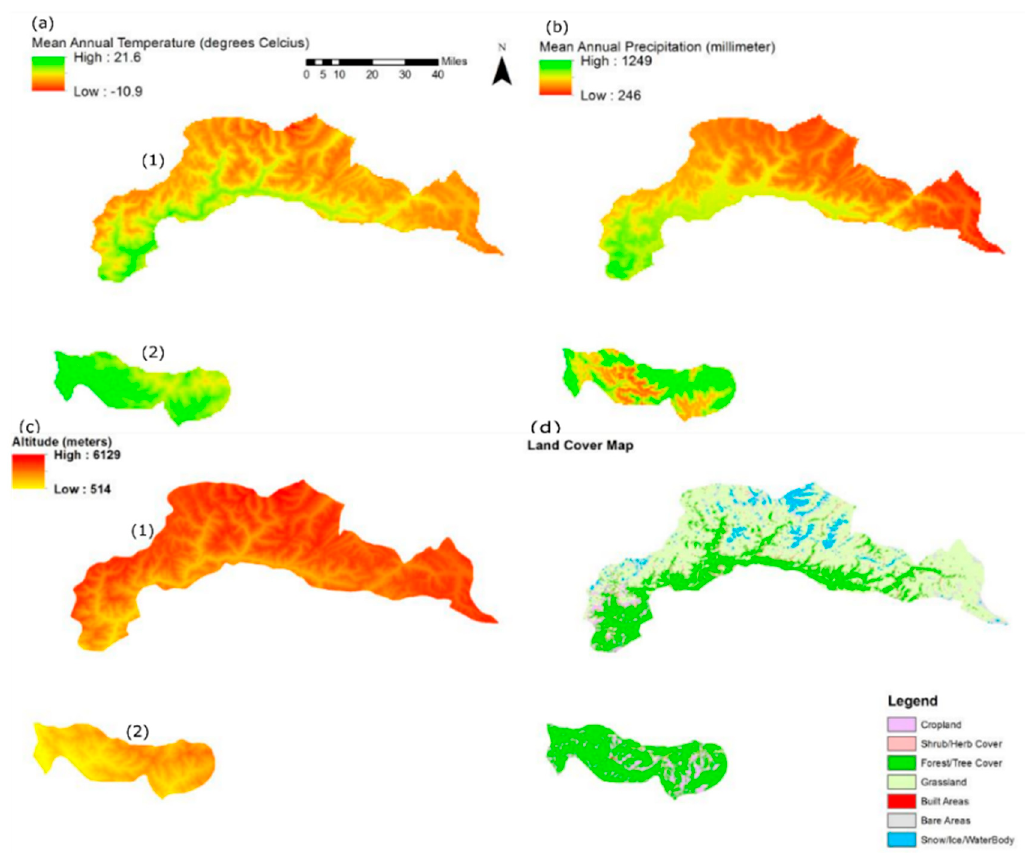
Figure 2. Topography, climatic conditions, and land cover of Neelum and Bagh in AJK. The climatic variables ( a , b ) were downloaded from www.worldclim.org. Altitude ( c ) was derived from the digital elevation model of NASA’s Shuttle Radar Topography Mission (SRTM) at 30 m spatial resolution. The land cover map ( d ) is extracted from the “The European Space Agency Climate Change Initiative(CCI)” global land cover product (www.esalandcovercci. Org, 300 m spatial resolution). All figures were prepared in ESRI ArcGIS 10.6.